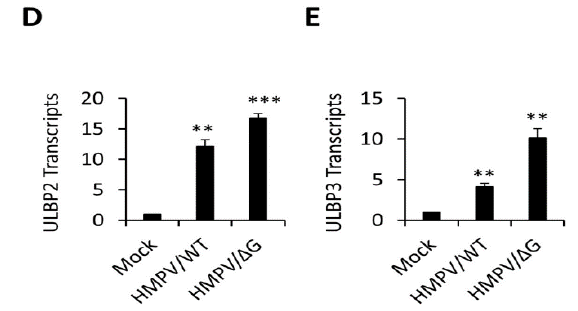
Figure 3. HMPV-infected A549 cells upregulate mRNA levels of natural killer group 2D (NKG2D) ligands. ( A – E ) Real Time PCR quantification of NKG2D ligands, major histocompatibility complex (MHC) class I polypeptide-related sequences A and B (MICA) ( A ), (MICB) ( B ), UL16 binding